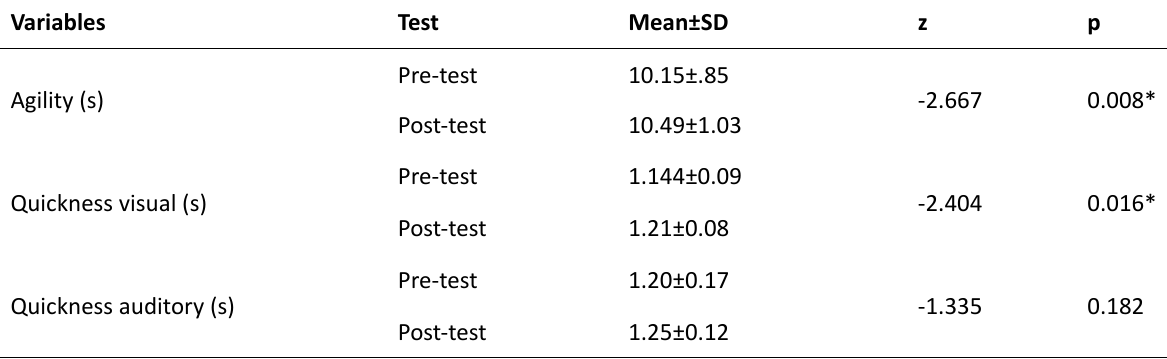
Table 4. Comparison of the agility and quickness pre-post test values of the athletes participating in the study Variables